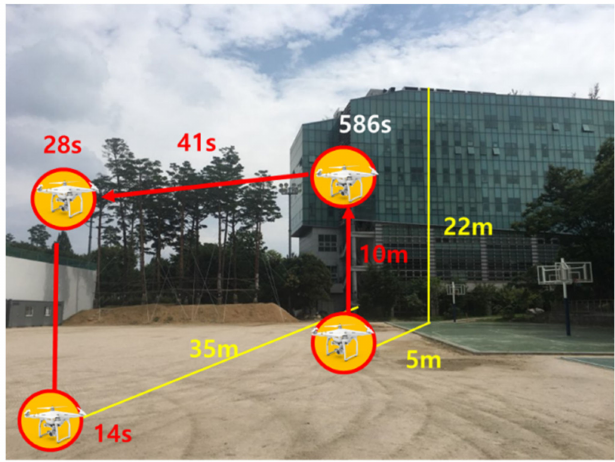
Figure 14. Dynamic test scenario.